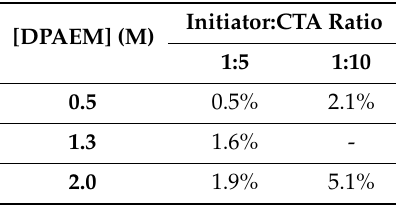
Table 3. Weight fraction of polymer in the MSN shell incorporated by grafting-from the nanoparticles in the presence of cross-linking agent ethylene glycol dimethacrylate (EGDMA) (gRAFT- cross